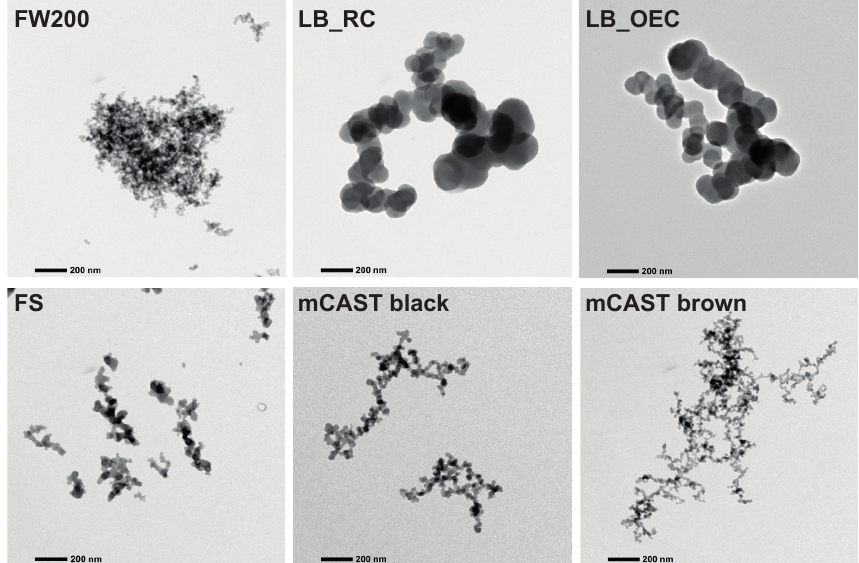
Figure 5. Sample TEM images of representative soot aggregates of the different soot types when selecting 400nm mobility diameter particles with the DMA.